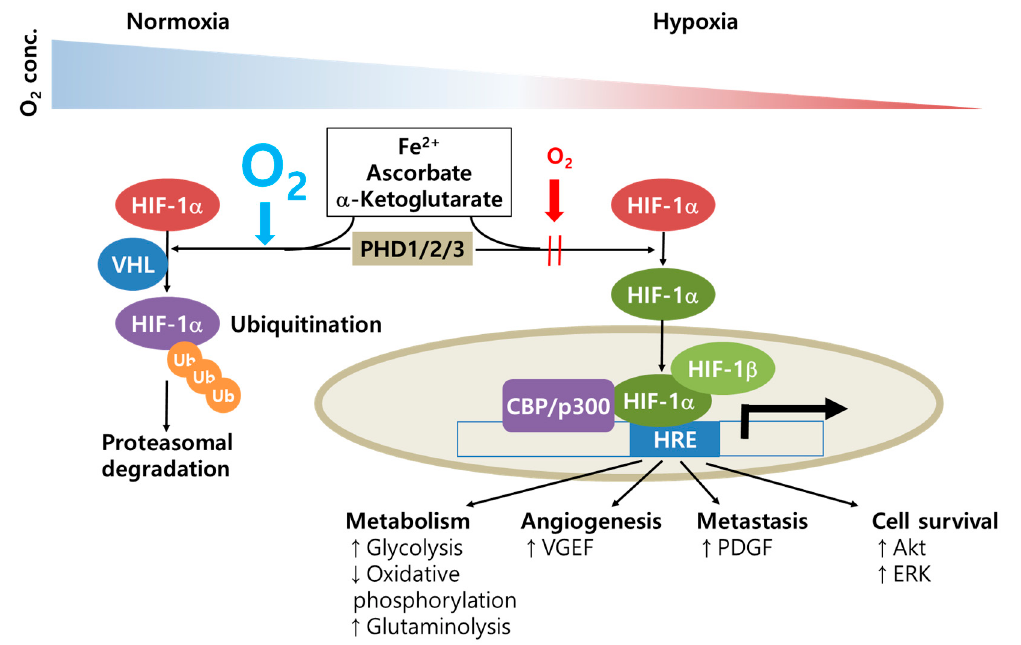
Figure3. Oxygen-dependentregulationofHIF-1 α incancercells. Undernormoxia, HIF-1 α isrecognized Figure 3. Oxygen-dependent regulation of HIF-1 α in cancer cells. Under normoxia, HIF-1 α is and hydroxylated by PHD in the presence of Fe 2 + , ascorbate, and α -ketoglutarate. Hydroxylated recognized and hydroxylated by PHD in the presence of Fe 2+ , ascorbate, and α -ketoglutarate. proline in HIF-1 α is recognized by VHL and subsequently ubiquitinated for proteasomal degradation. Hydroxylated proline in HIF-1 α is recognized by VHL and subsequently ubiquitinated for However, under hypoxic conditions, HIF-1 α is stabilized and translocated into the nucleus, where it is proteasomal degradation. However, under hypoxic conditions, HIF-1 α is stabilized and translocated dimerized with HIF-1 β . Following the binding of the HIF-1 α -HIF-1 β complex with other cofactors into the nucleus, where it is dimerized with HIF-1 β . Following the binding of the HIF-1 α -HIF-1 β (such as CBP / p300), the molecules can target the HRE, which is involved in the metabolic switch, complex with other cofactors (such as CBP/p300), the molecules can target the HRE, which is involved angiogenesis, metastasis, and cell survival. Abbreviations: CBP, cAMP response element binding in the metabolic switch, angiogenesis, metastasis, and cell survival. Abbreviations: CBP, cAMP protein; HRE, hypoxia response elements; p300, E1A binding protein; PHD, proxyl hydroxylase protein; response element binding protein; HRE, hypoxia response elements; p300, E1A binding protein; PHD, Ub, ubiquitin; VHL, von Hippel–Lindau proxyl hydroxylase protein; Ub, ubiquitin; VHL, von Hippel–Lindau protein.